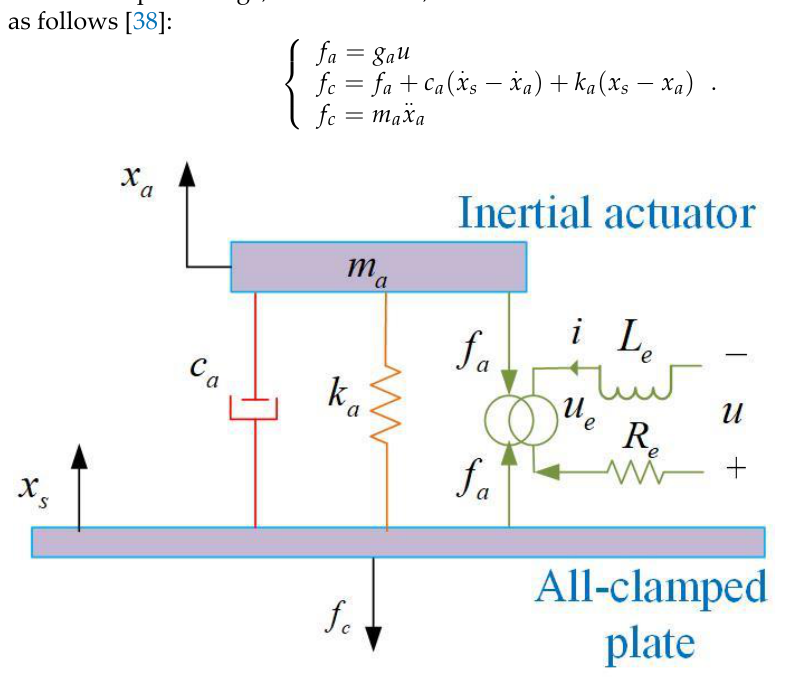
Figure 1. Diagram of the all‑clamped plate with the inertial actuator.